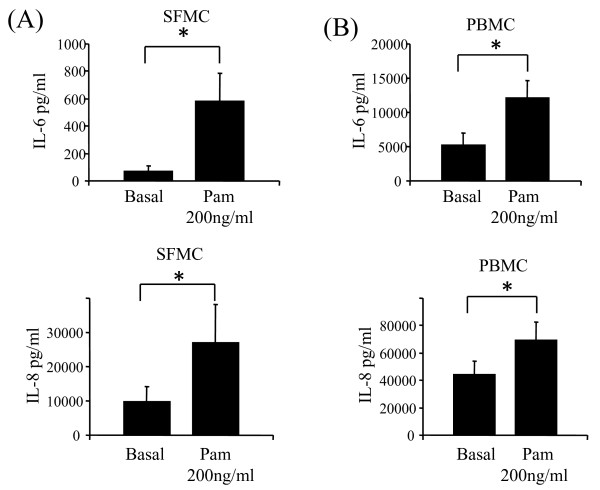
Pam3CSK4 induced IL-6 and IL-8 in mononuclear cells from RA patients. SFMCs (A; n = 6) and PBMCs (B; n = 11) were stimulated with TLR2 agonist Pam3CSK4 at 200 ng/ml. Levels of IL-6 and IL-8 in the culture supernatants were determined and compared to unstimulated cells (Basal) at six hours. Values are expressed as the mean ± SEM. * P < 0.05, significantly different from control as determined using Wilcoxon Signed Rank analysis.